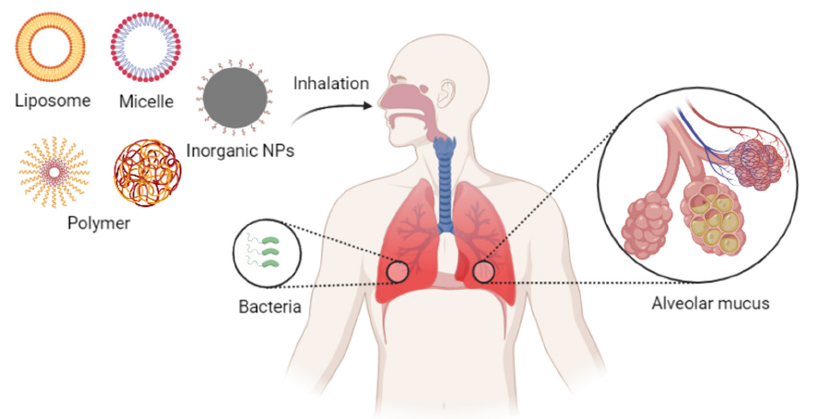
Figure 12. Inhalation nanoformulations for overcoming pulmonary delivery barriers.